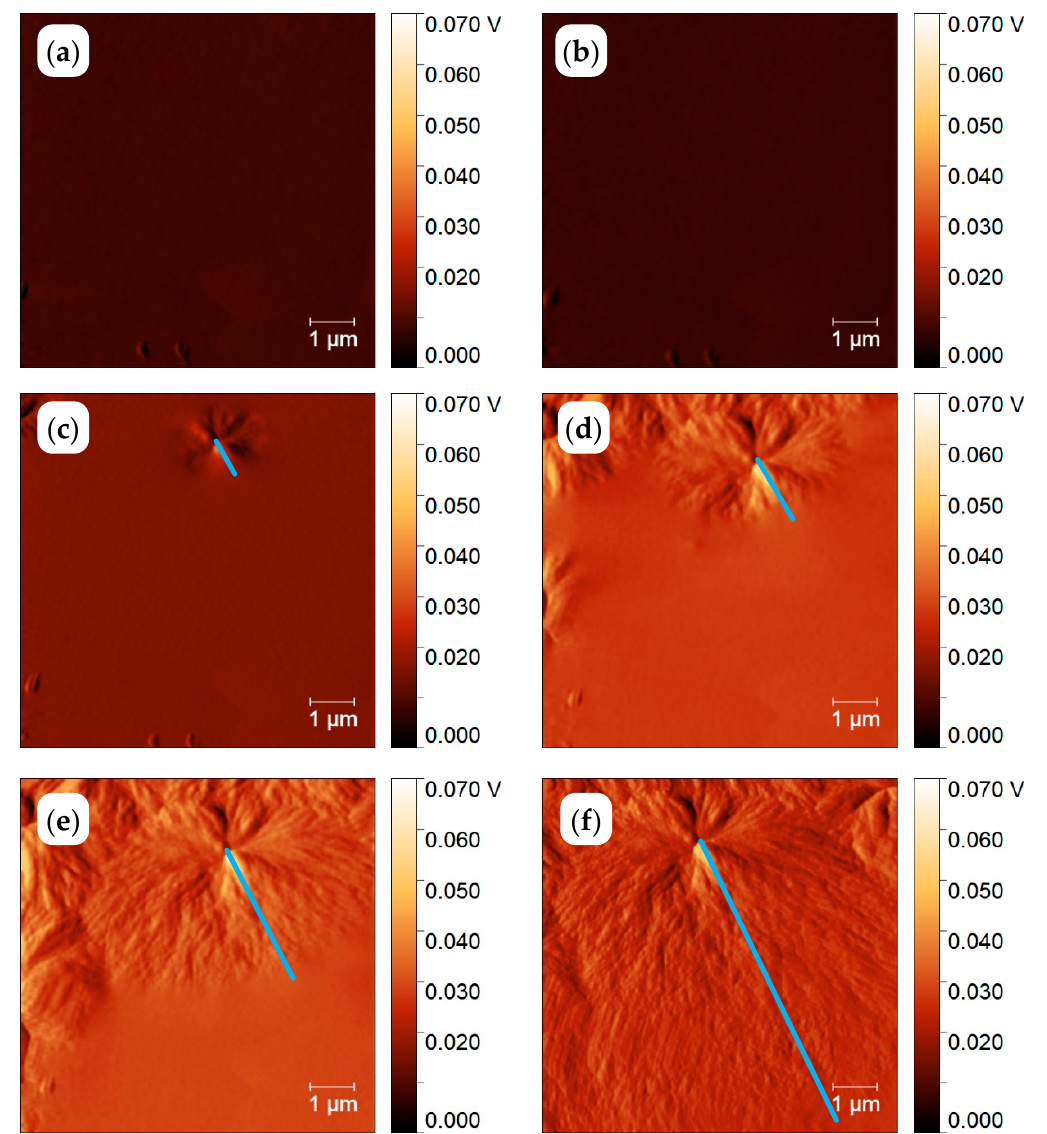
Figure 8. AFM amplitude images showing an area of 8 × 8 µ m 2 . PEEK annealed at 564 K for 0.01 s ( a ), 0.1 s ( b ), 1 s ( c ), 2 s ( d ), 4 s ( e ) and 10 s ( f ). The reason for the slight asymmetry of the growth rate in direction of the blue line and perpendicular to it, images ( d , e ), is not yet known and was not investigated.